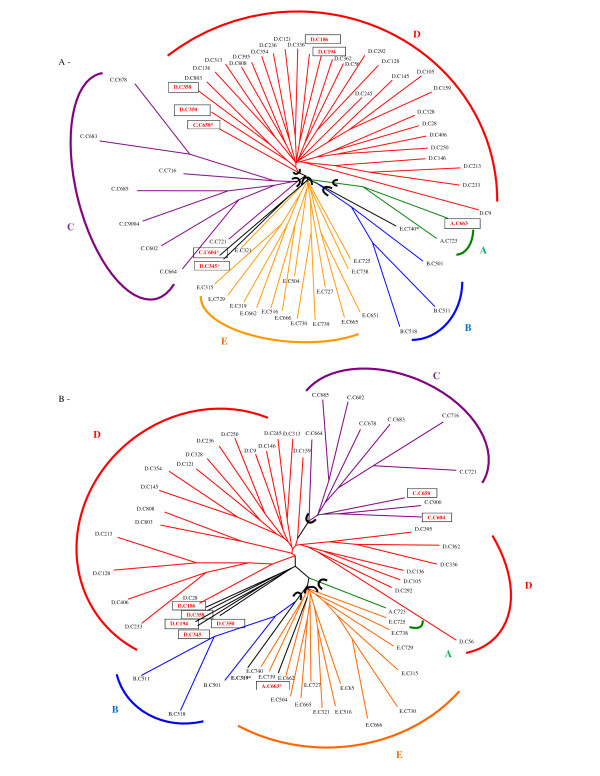
Unrooted trees of individual wild Coffea canephora genotypes using the neighbour-joining method and shared-allele distance among (A) 16 microsatellite loci and (B) 8 RFLP loci. The first letter of the individual labels, A, B, C, D and E, indicates the a priori diversity group of Dussert et al. [35]. Individuals who appear to be misclassified in the present tree are marked (*). Circled names represent plants identified as being miss-classified or putative hybrids by the subsequent genetic structure analysis.